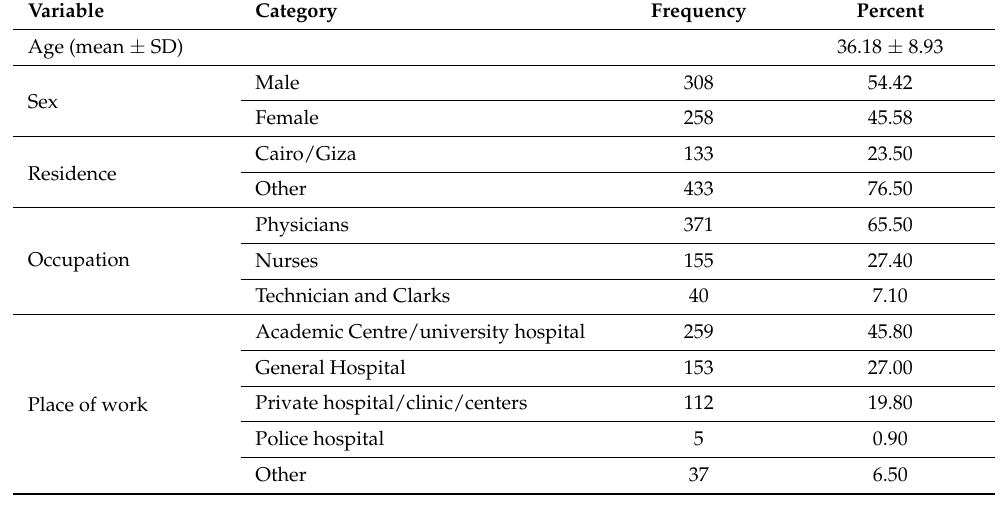
Table 1. Sociodemographic characteristics of the participants, (n = 566).